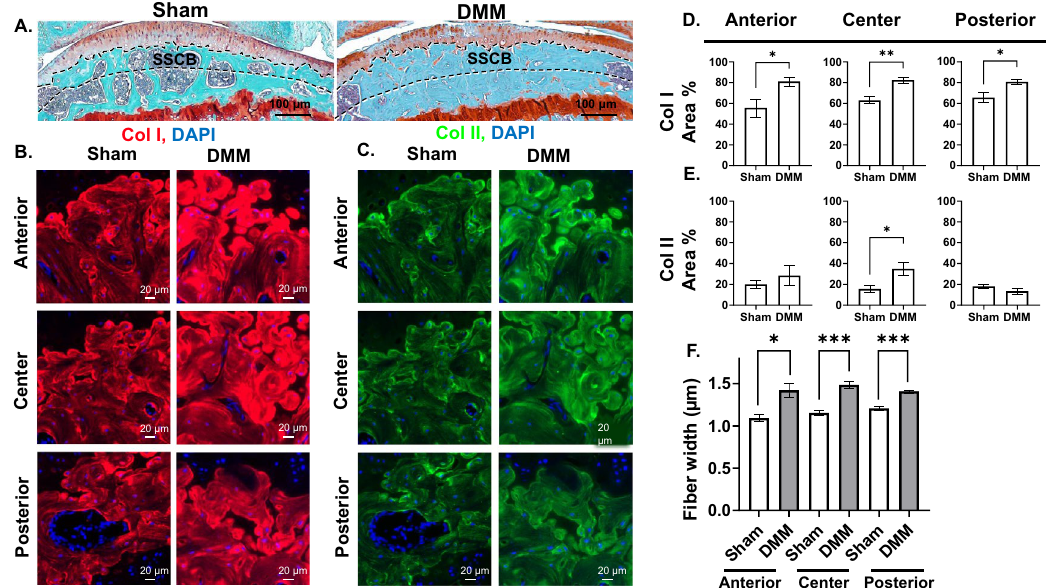
Figure 3. OA results in increased collagen composition and increased fiber thickness in the superficial regions of subchondral bone. ( A ) Safranin-O/Fast Green staining depicting the superficial SCB (SSCB) (10 × magnification, scale bar = 100 μm, images acquired with OsteoMeasure software). IF staining for ( B ) Col I and ( C ) Col II expression in anterior, center, and posterior regions of the superficial SCB (× 40 magnification, scale bar = 20 μm, images acquired with Zeiss Zen Blue 2.6 edition software). Quantification of area percentage (area of positive signal normalized to total selected area) of ( D ) Col I and ( E ) Col II IF stains. ( F ) Comparison of FSHG fiber width (μm) between sham and DMM samples in each ROI. * P < 0.05, ** P < 0.01, *** P < 0.001 using unpaired t-test with Welch’s correction, values are expressed as mean ± SEM; 3 images were analyzed per ROI in each sample, N = 5/group.